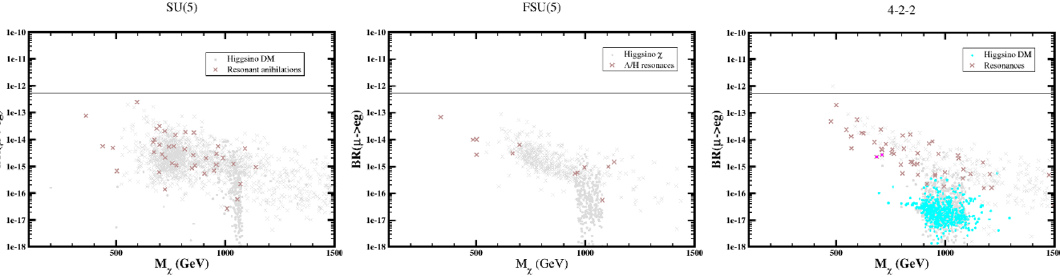
Figure 3 . Prediction for BR( (cid:22) ! e(cid:13) ) vs m (cid:31) for (from left to right) the SU(5), the FSU(5) and 4-2-2 models, in scenarios where sfermions coannihilate with the LSP. We use the same notation for the DM models as in (cid:12)gure 2. Models with parameters not detectable at the LHC are marked in grey, while excluded models are marked with purple dots. We assume M N = 2 : 5 (cid:1) 10 12 GeV in all three cases.